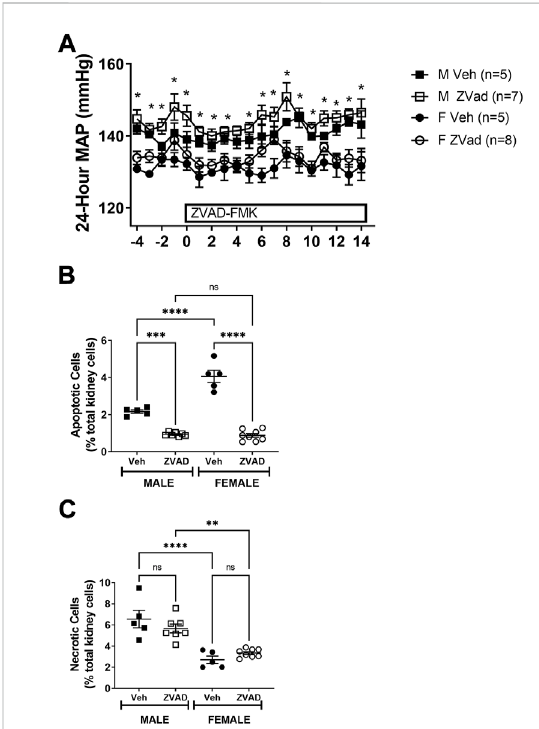
FIGURE 4 Treatment with ZVAD-FMK for 2 weeks lowers renal apoptosis, but did not change BP in male or female SHR. Mean arterial blood pressure (MAP) was measured via telemetry in male (M) and female (F) spontaneously hypertensive rats (SHR) treated with vehicle (veh) or ZVAD-FMK (ZVAD) from 13 to 15 weeks of age [panel (A) ; n = 5 – 8]. Apoptotic [panel (B) ] and necrotic [panel (C) ] cell death were measured by fl ow cytometric analysis and expressed as % of total gated kidney cells in the same rats. MAP data within each sex were analyzed using repeated measures ANOVA with Tukey ’ s multiple comparisons test. Between group comparisons were made by 2-way ANOVA; * indicates p < 0.05 vs. female SHR. Flow cytometry data were compared using 2-way ANOVA followed by Tukey ’ s multiple comparisons test; **** indicates p < 0.0001; *** indicates p = 0.0001; NS indicates not signi fi cant.